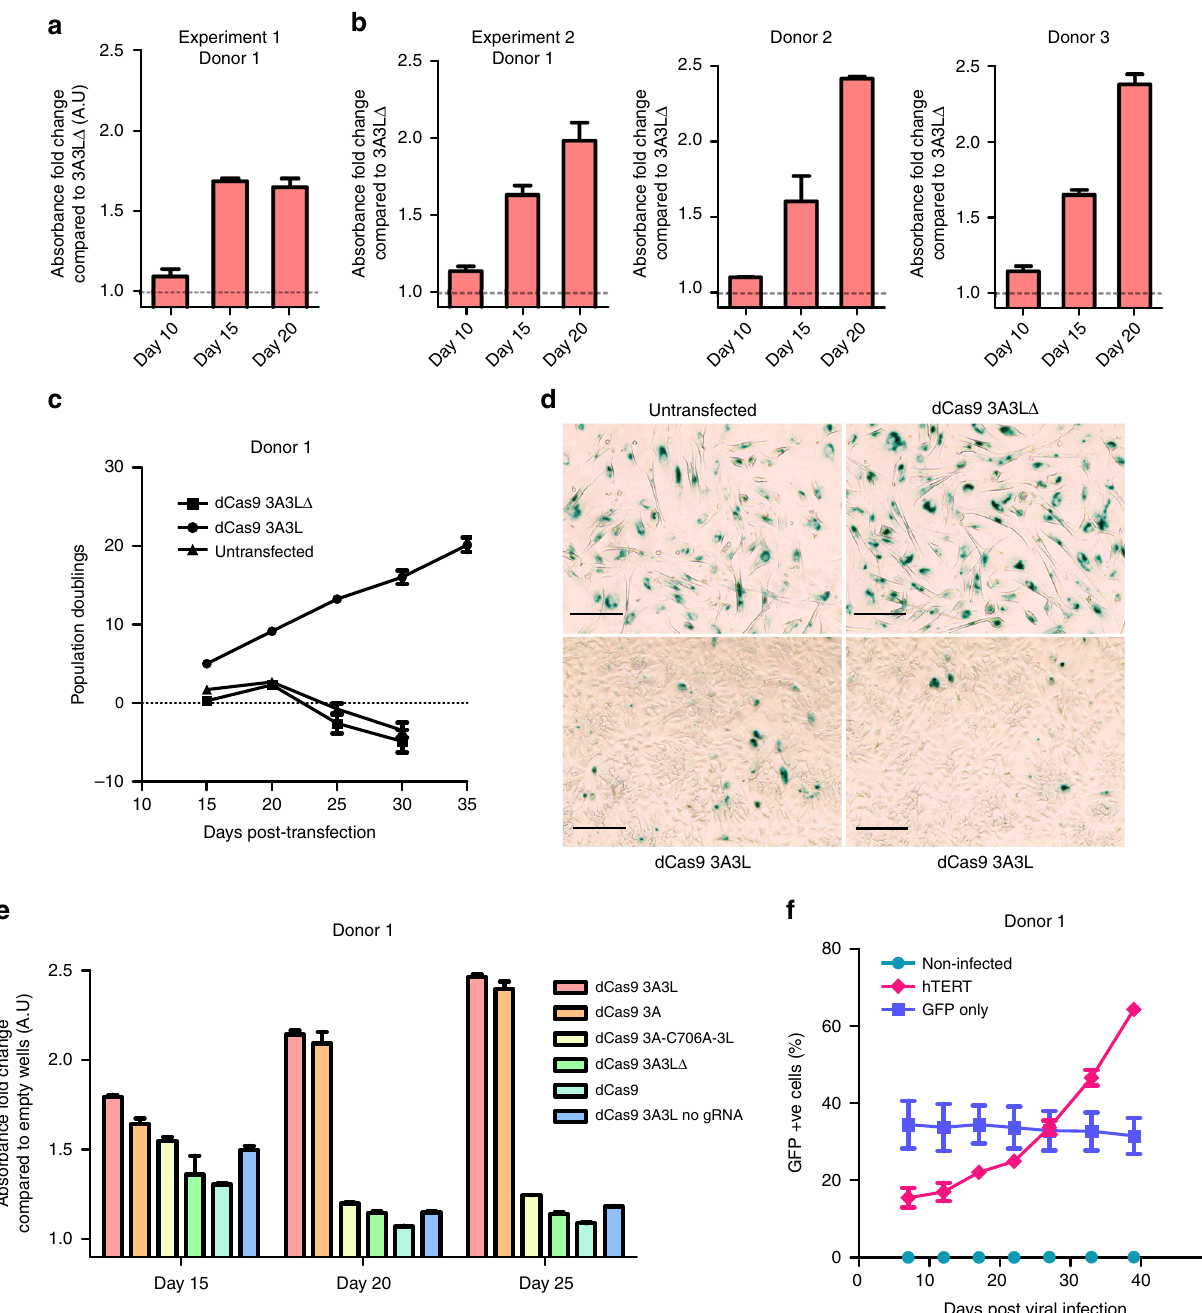
Fig. 3 dCas9 3A3L or dCas9 3A targeting prevents senescence and increases proliferation. a , b Proliferation was assessed using a colorimetric assay 10, 15 and 20 days after targeting dCas9 3A3L to HIC1 , RASSF1 , PTEN and CDKN2A and magnetic sorting in primary myoepithelial cells from donors 1, 2 and 3. Dotted line represents the average absorbance from three dCas9 3A3L Δ targeted wells at each timepoint. The graphs show the average difference in absorbance as fold change compared to 3A3L Δ average (mean ± SEM, n = 3). c Cumulative population doublings over time for untransfected primary myoepithelial cells and those transfected with dCas9 3A3L or 3A3L Δ targeting the four genes without magnetic sorting from donor one. Fifty thousand cells were seeded at the start of each passage and cells counted after 5 days (mean ± SEM, n = 3, where error bars are smaller than points plotted they are not shown). ( d ) Light microscopy images of β -gal staining from untransfected (top left) primary myoepithelial cells from donor 1 and those transfected with dCas9 3A3L (bottom two) or 3A3L Δ (top right) targeting the four genes without magnetic sorting 20 days after transfection, blue/green colouring shows β -gal +ve cells; scale bar represents 125 µ m. e Proliferation was assessed using a colorimetric assay 15, 20 and 25 days after targeting the four genes with dCas9 3A3L (red), dCas9 3A (orange), dCas9 3A-C706A-3L (yellow), dCas9 3A3L Δ (green) or dCas9m4 (pale green), or targeting only dCas9 3A3L without gRNAs (blue) without magnetic sorting using donor 1 myoepithelial cells. The data is shown as fold change compared to the average absorbance from 3 wells without cells (mean ± SEM, n = 3). f The percentage of GFP +ve cells after infection with no virus (green), hTERT with GFP marker (pink) or GFP control (purple). At infection day 0 cells are 38 days post-transfection with dCas9 3A3L targeting the four genes (mean ± SEM; n = 3, error bars are not shown where smaller than points